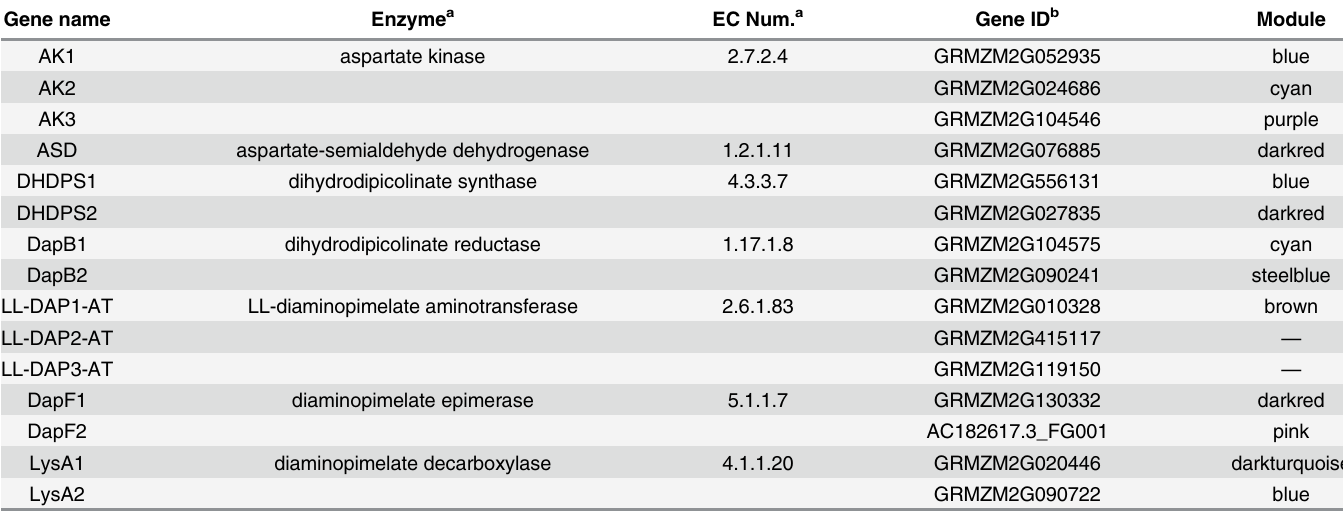
Table 1. Lysine biosynthesis pathway enzyme genes in